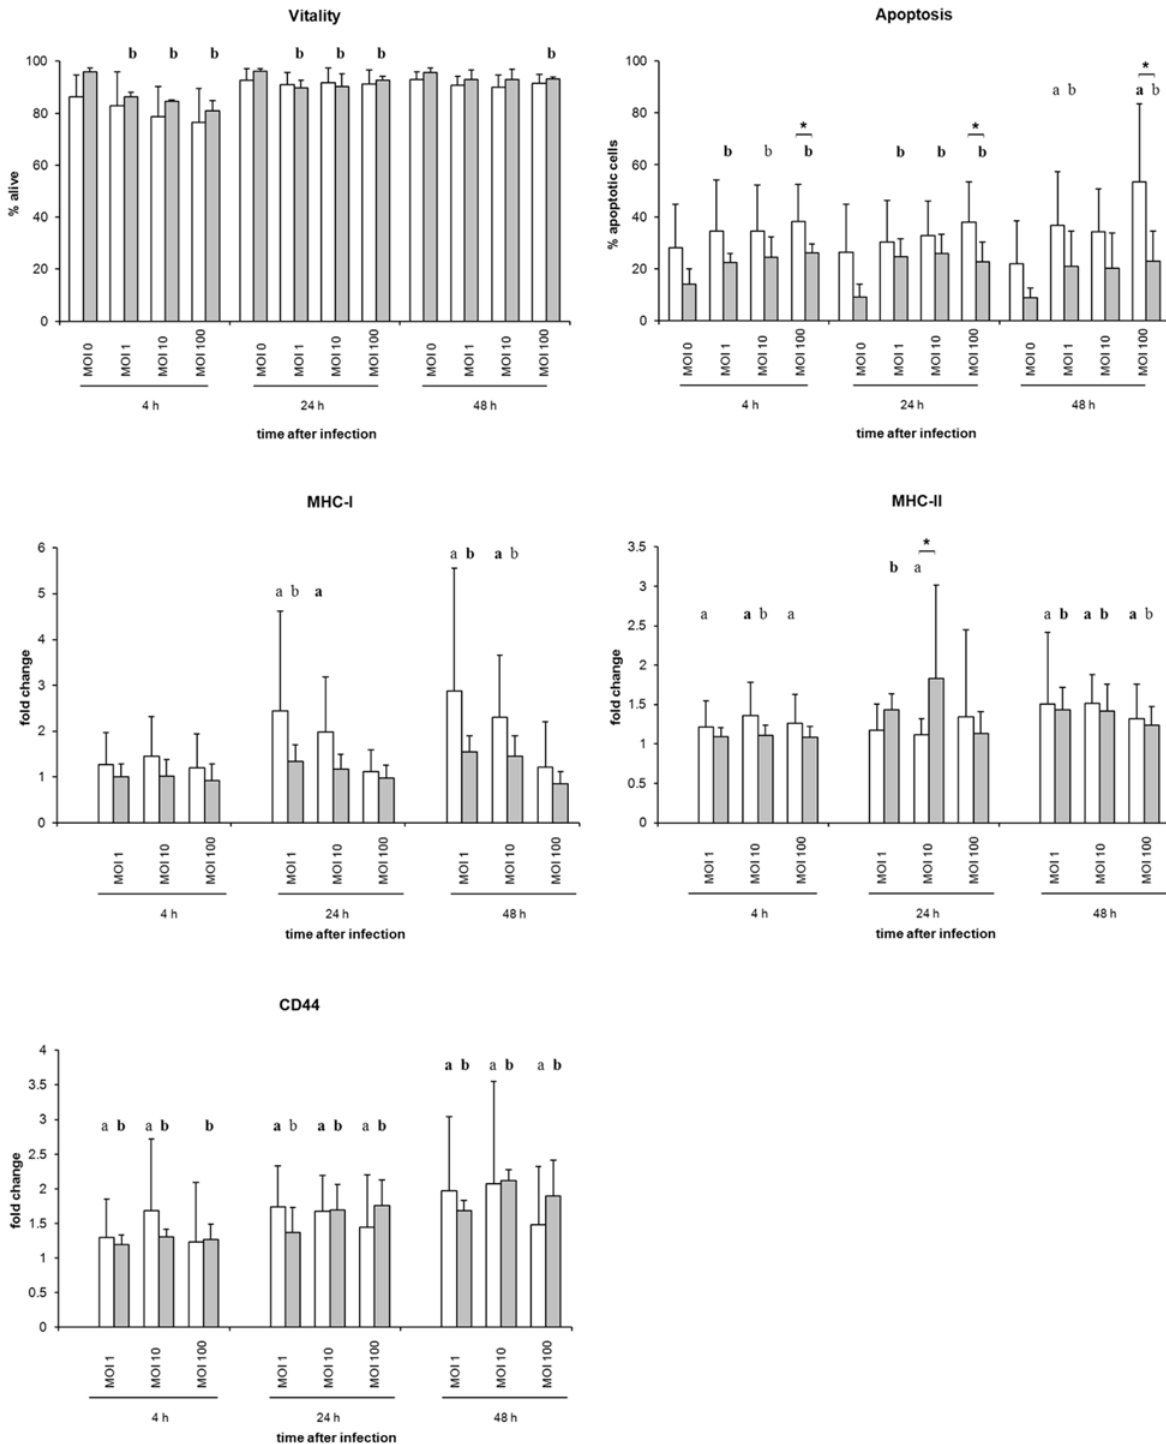
Fig 4. Flow cytometric analysis of primary avian macrophages after infection. The vitality of avian macrophages was defined by propidium iodide. Apoptotic cells were stained using Annexin V Fluos. Diagrams additionally show fold changes of fluorescence intensity of S . Typhimurium- and S . Infantis- infected avian macrophages after staining with different monoclonal antibodies. White columns — macrophages infected with S . Typhimurium (n = 4), Grey columns — macrophages infected with S . Infantis (n = 4) ** P (cid:2) 0.05 or * P (cid:2) 0.1 S . Typhimurium vs. S . Infantis; a ) P (cid:2) 0.05 or a) P (cid:2) 0.1 S . Typhimurium vs. control; b ) P (cid:2) 0.05 or b) P (cid:2) 0.1 S . Infantis vs. control.